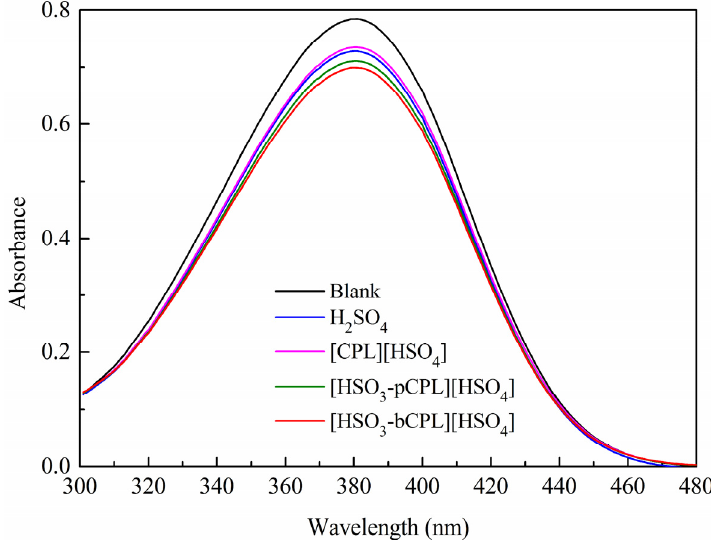
Figure 1. Absorption spectra of 4 ‐ nitroaniline for various ILs in methanol.